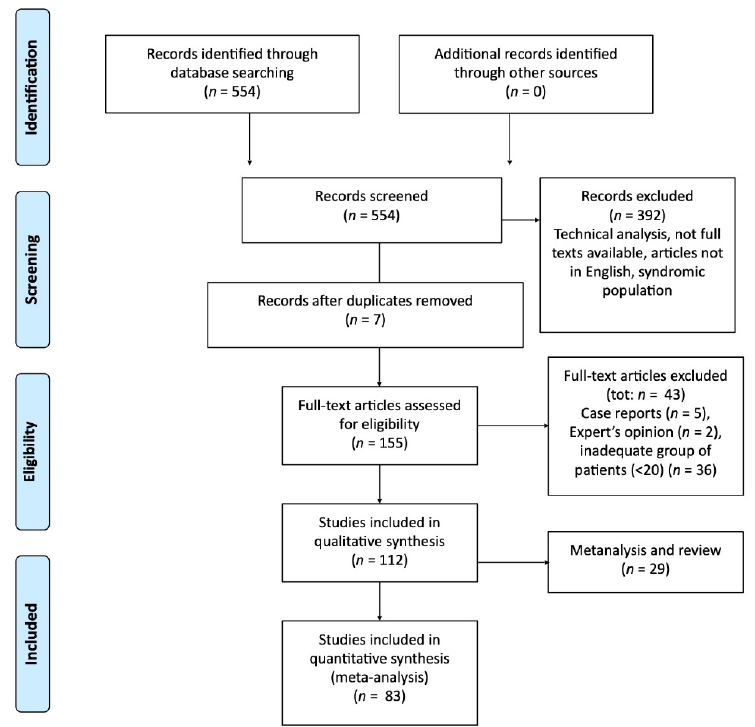
Figure 1. Literature evaluation and selection, according to PRISMA criteria (http://www.prisma- statement.org/ (accessed on 16 July 2022).